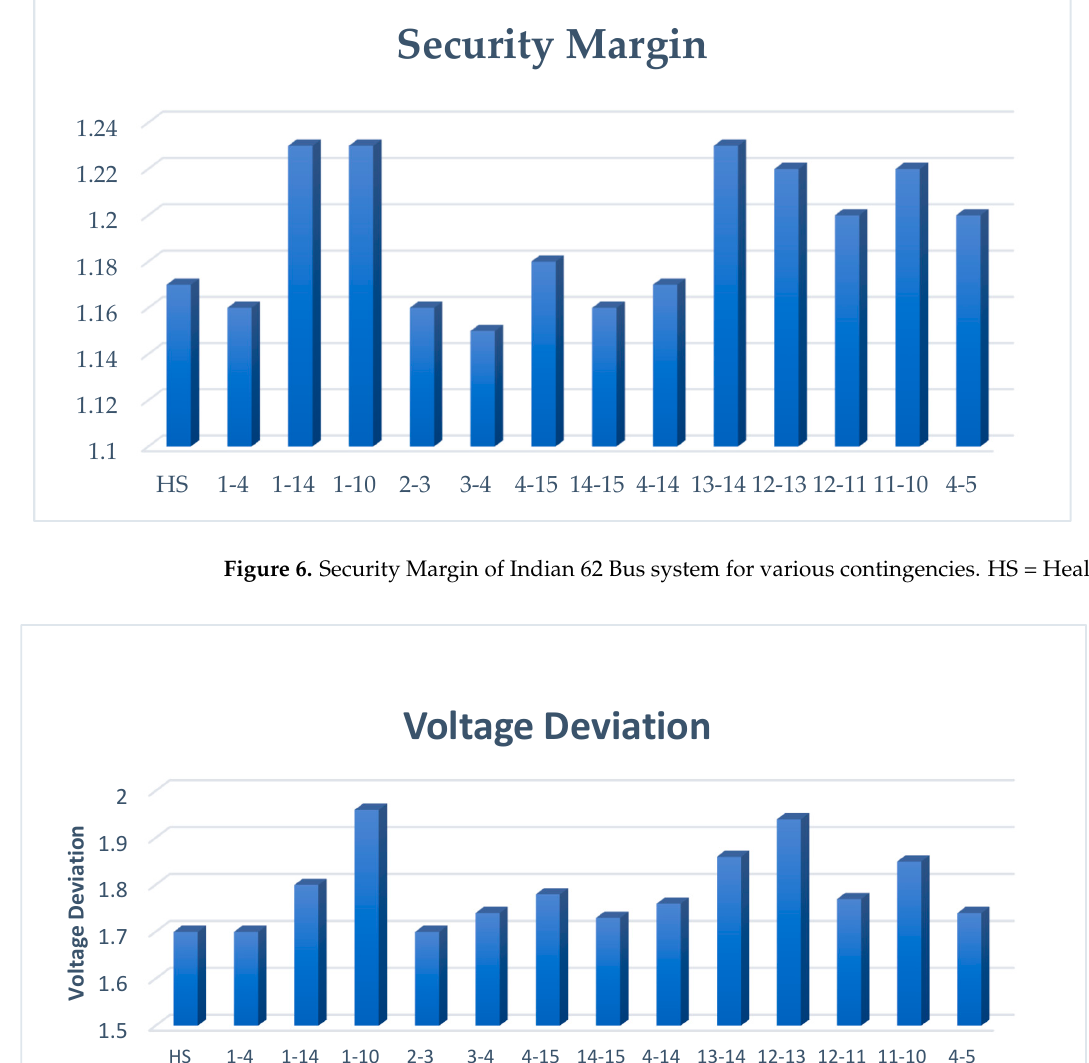
Figure 5. Active Power Loss in various line contingencies. HS = Healthy System.